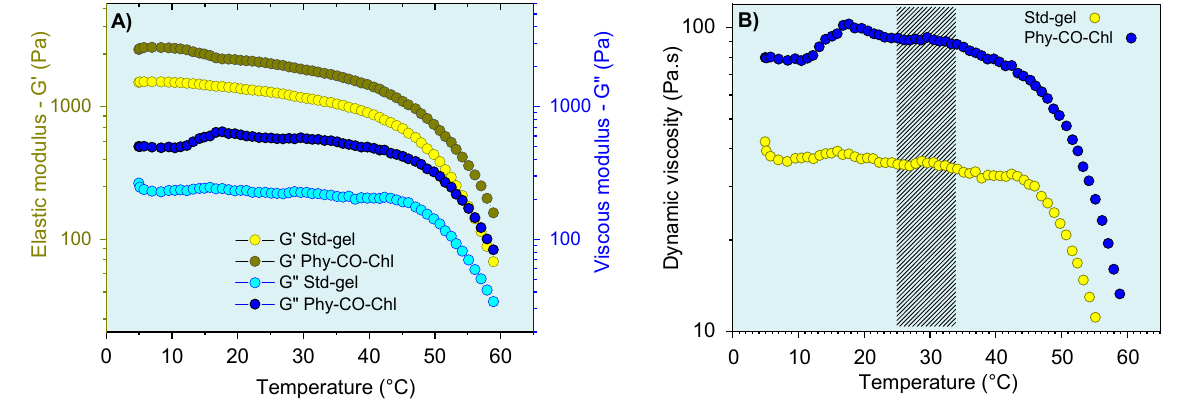
Figure 8. Viscoelastic properties of the gel formulations as a function of temperature: ( A ) storage modulus (G’) and ( B ) dynamic viscosity. The marking in ( B ) corresponds to the variation between temperatures of 25 °C (room temperature) and 32 °C (skin temperature). Standard deviations were omitted for clarity; however, the coefficient of variation of the replicate analyzes was <10% in all cases. Regarding oscillatory rheometry, an analysis within the linear viscoelastic region (fixed stress values ranging from 2.5 to 8 Pa, depending on the formulation) was employed at skin temperature (32 °C) (Figure 9). This region allows infinitesimal deformation, and the biopolymer chains are kept close to equilibrium. Thus, the oscillatory responses showed molecular-level interaction information. The viscoelastic properties were verified by obtaining the G’ and G” moduli. Their relationship, expressed as G”/G”, showed vis- coelastic behavior when the values were less than one. In this condition (G”/G’ < 1 ), there was a predominance of elastic interactions and of reversible nature [69].